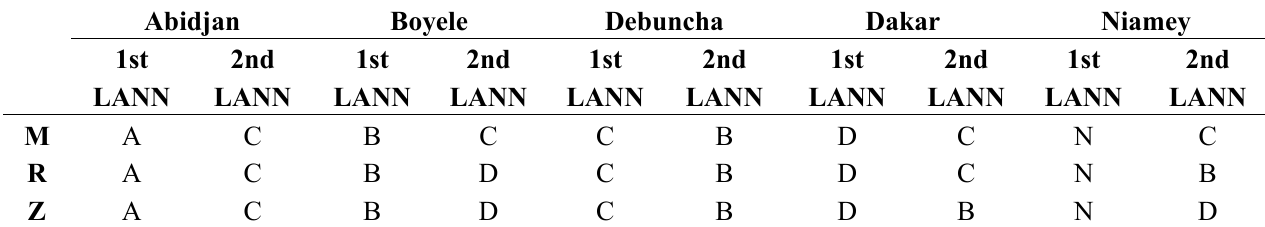
Table 5. Choice of the two best LANN for retrieval of the parameters in the different localities (A, B, C, D and N).